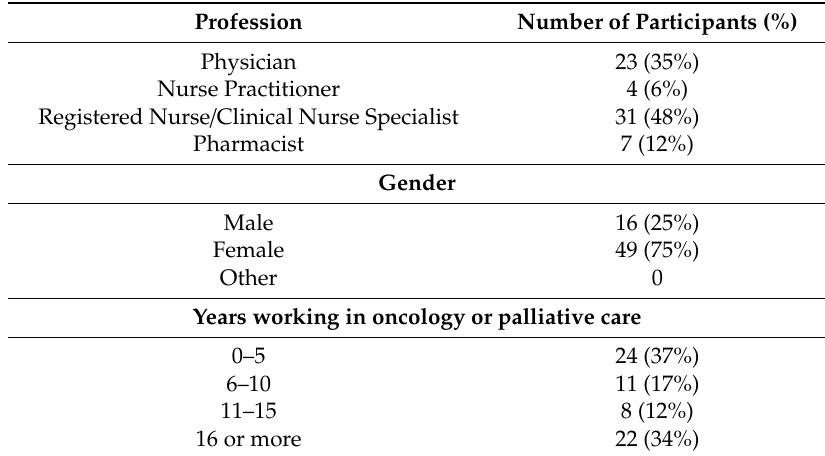
Table 1. Demographic characteristics of survey participants ( n =